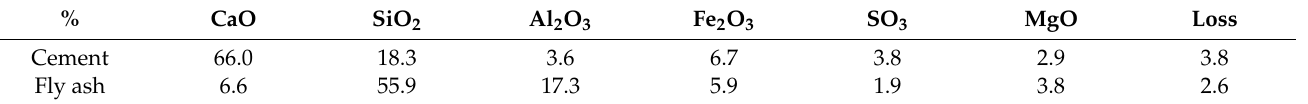
Table 2. Chemical composition of cement and fly ash.